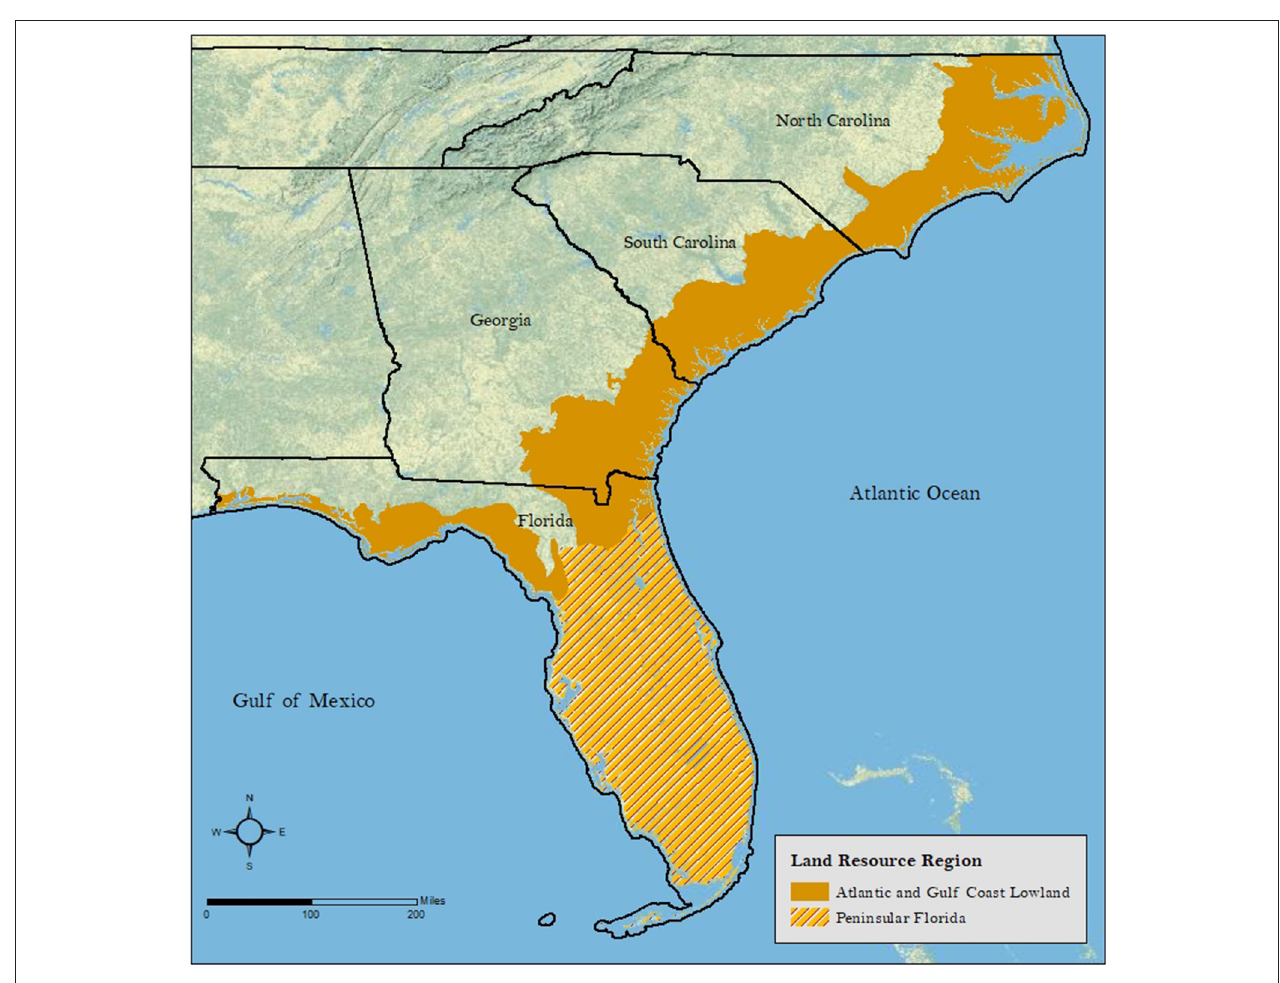
FIGURE 1 | Coastal regions of the Southeastern United States defined using the U.S. Department of Agriculture-classified Land Resource Regions of the outer coastal plain (Atlantic and Gulf Coast Lowland) and peninsular Florida (Map data source: https://www.nrcs.usda.gov/wps/portal/nrcs/detail/national/technical/nra/